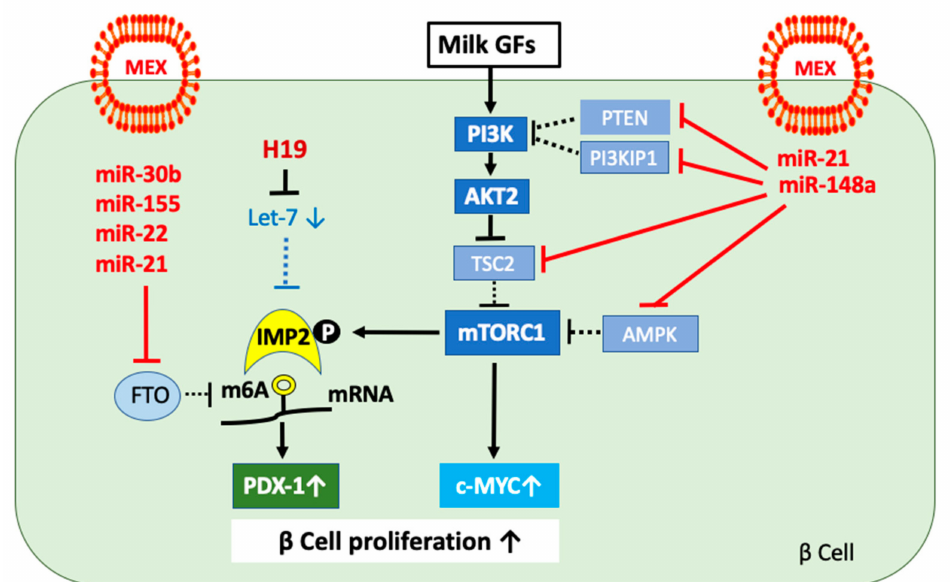
Figure 5. Potential impact of milk exosome (MEX) miR-mediated N6-methyladenosine (m6A) RNA modification of pancreas/duodenum homeobox protein 1 (PDX-1). MEX miR-induced suppression of fat mass- and obesity-associated gene ( FTO ) may stabilize m6A on PDX1 mRNA, enhancing PDX-1 expression and promoting β cell proliferation. MEX miR-stimulated activation of mTORC1-mediated phosphorylation of insulin-like growth factor 2 mRNA-binding protein 2 (IMP2) as well as